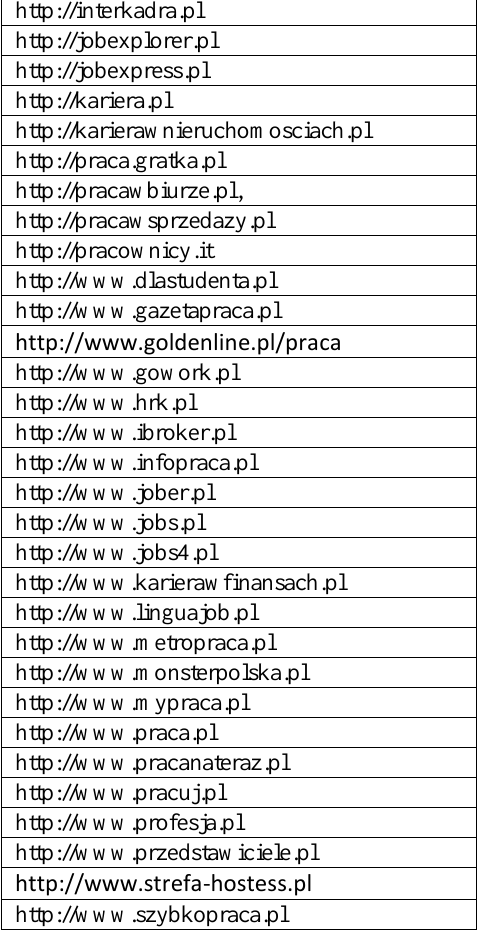
Table 2 : A list of Polish internet websites with job